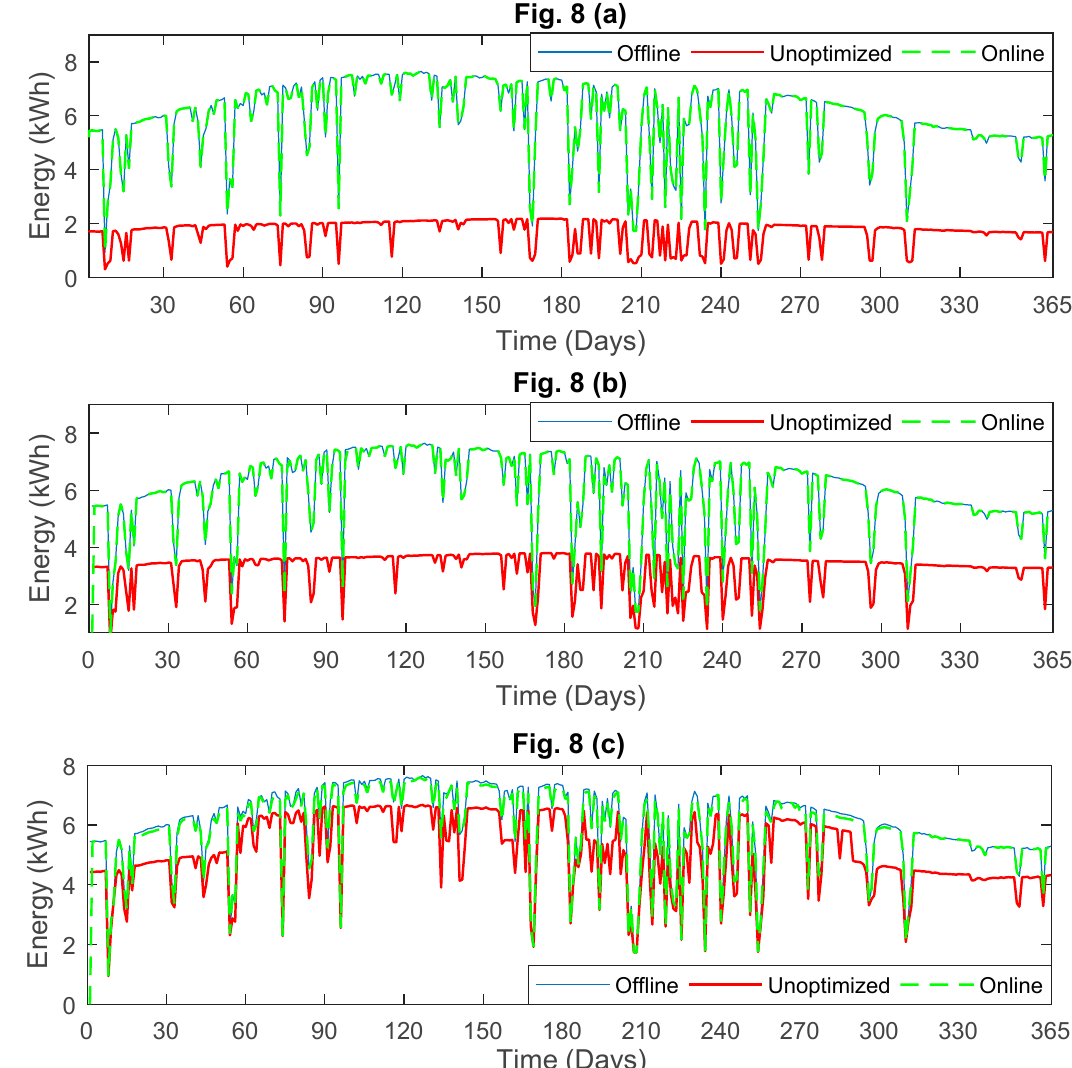
Figure 8. Solar energy utilization for various load shedding scenarios. ( a ) for 4-h load shedding (grid unavailable); ( b ) for 8-h load shedding (grid unavailable); ( c ) for 12-h load shedding (grid unavailable).